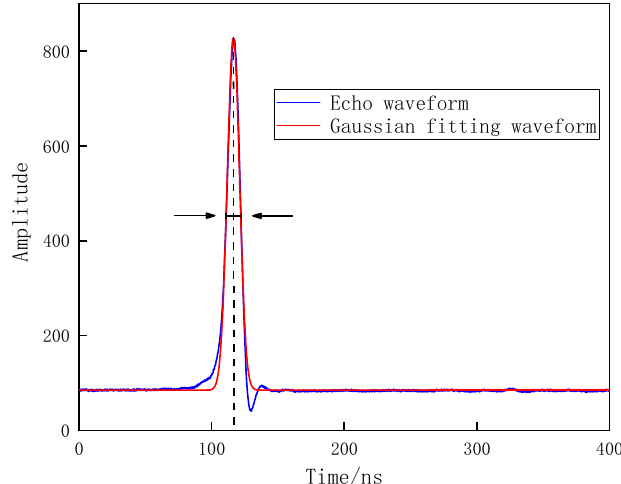
Figure 4. Parameter extraction of the laser echo waveform.